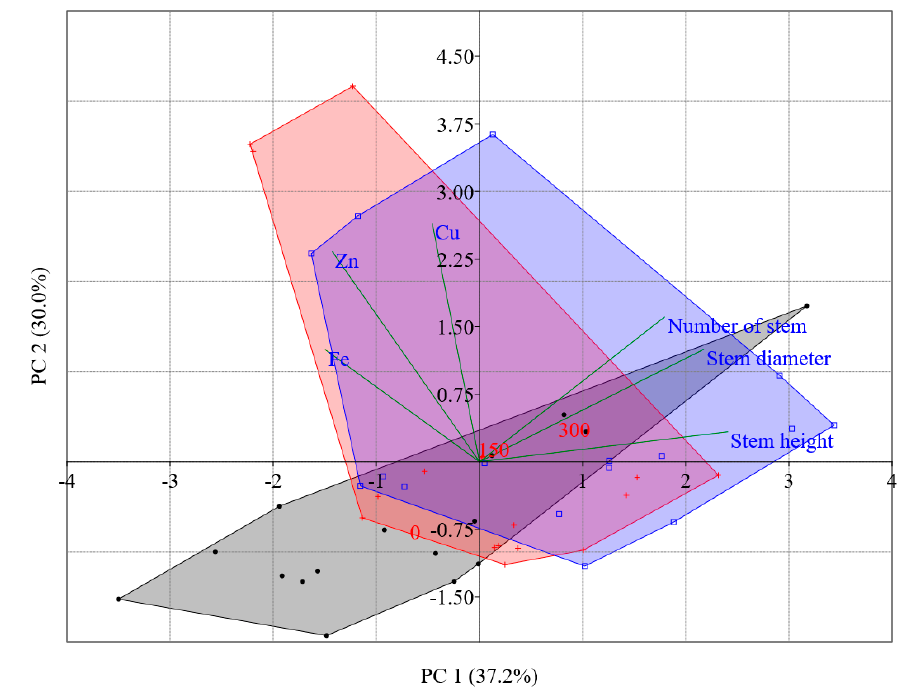
Figure 9. Scores and loadings of principal component analysis (PCA) carried out on the set of plant morphological data and microelements present in the leaves (Cu, Fe, and Zn) collected over a period of 28 days from Cu contamination.